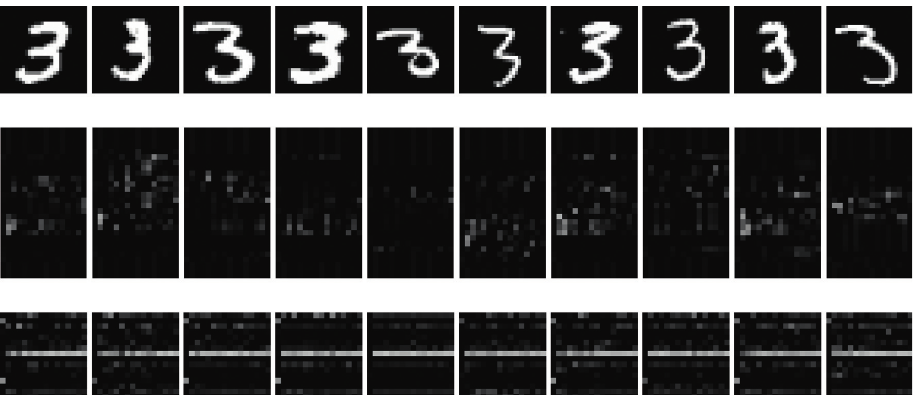
Figure 4: The spatial feature extracted for digit “3” in MNIST data. The first row: ten random samples; the second row: results of the proposed method by column-lifted IMKPCA; the third row: results of row-lifted IMKPCA for the second row; input: image matrix of size 28 × 28; output: feature matrix of size 16 × 16.